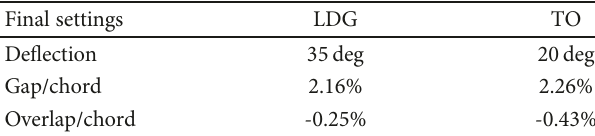
Figure 15: Computed pressure coe ffi cients at high angle of attack without droop nose device. Table 6: Flap setting for the high-lift